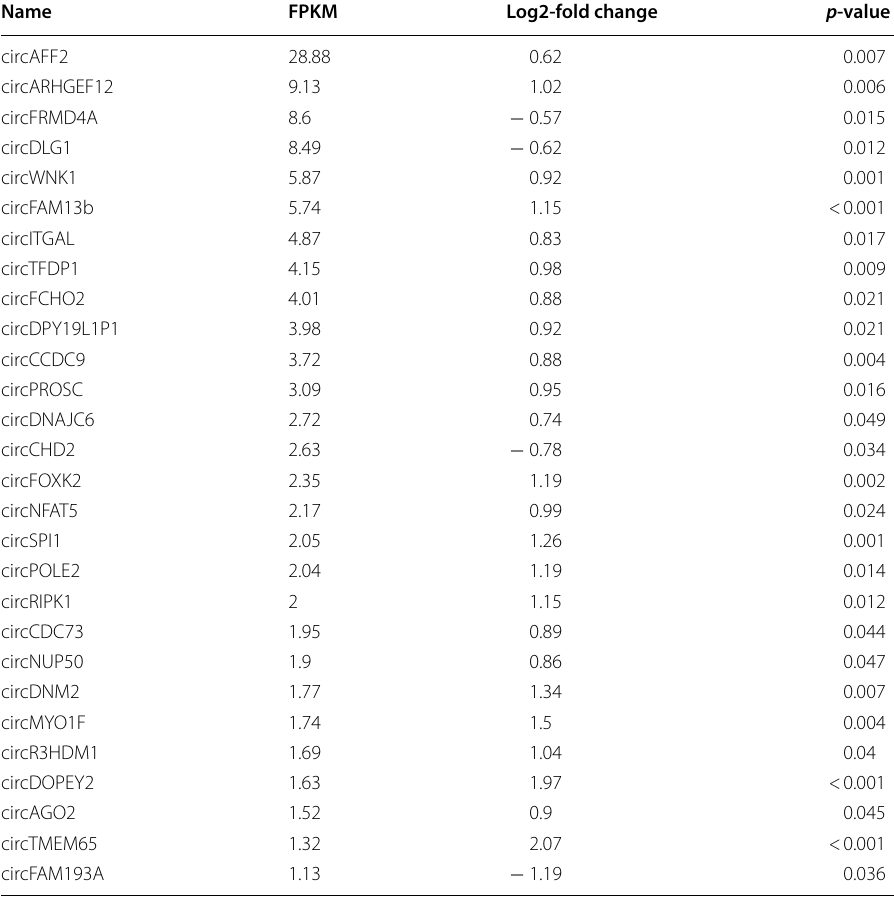
Table 2 List of 28 circRNAs selected from RNA‑seq Name